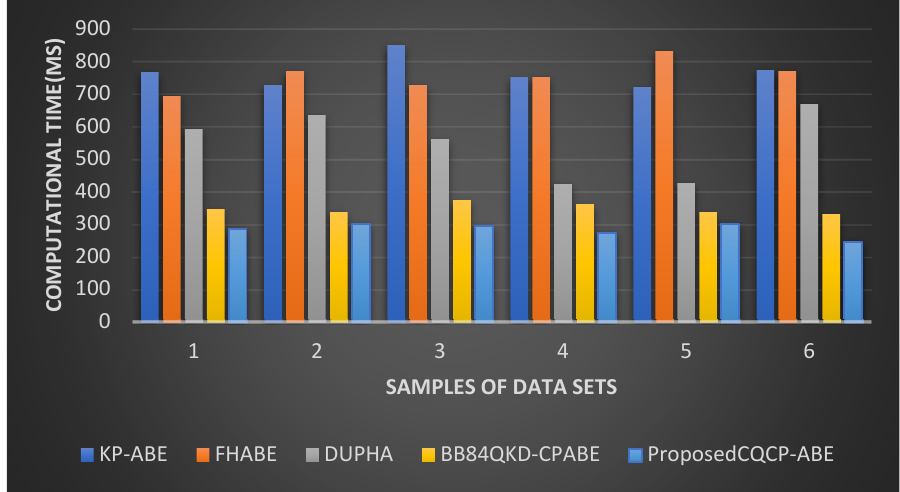
Figure 8, exemplifies the comparative analysis of the Hybrid QCPABE over the con ‐